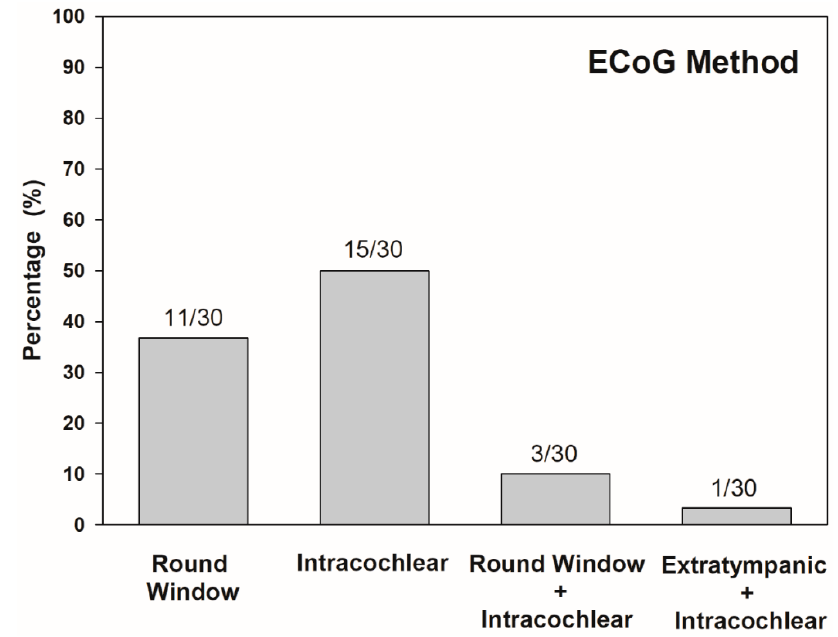
Figure3. DistributionofECoGmethodinpercentageacrossallpapersreviewed( n = 30). Numbersabove Figure 3. Distribution of ECoG method in percentage across all papers reviewed ( n = 30). Numbers bars indicate number of studies corresponding each above bars indicate number of studies corresponding each method.